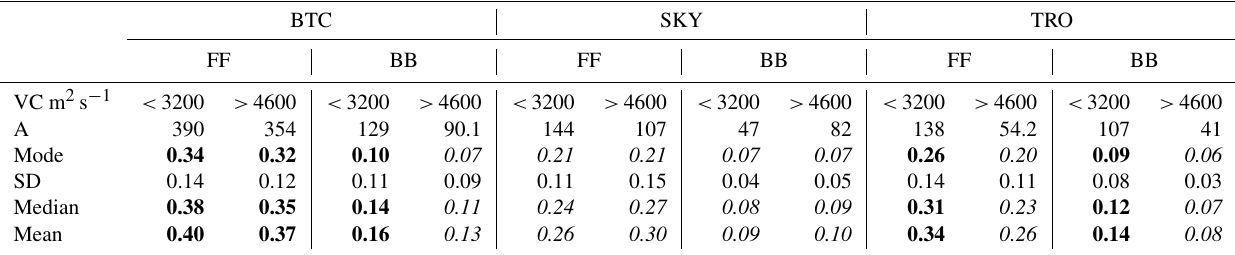
Table 4. Fitting parameters of the lognormal EF distributions g(kgfuel) − 1 measured at the three locations under low (VC < 3200m 2 s − 1 ) and high (VC > 4600m 2 s − 1 ) ventilation conditions (see Fig. 6). The total number of cases ( A ) as well as the derived median and mean values were also presented. Bold numbers denote the EFs of direct sources, while italic numbers refer to EFs from transported pollution. BTC